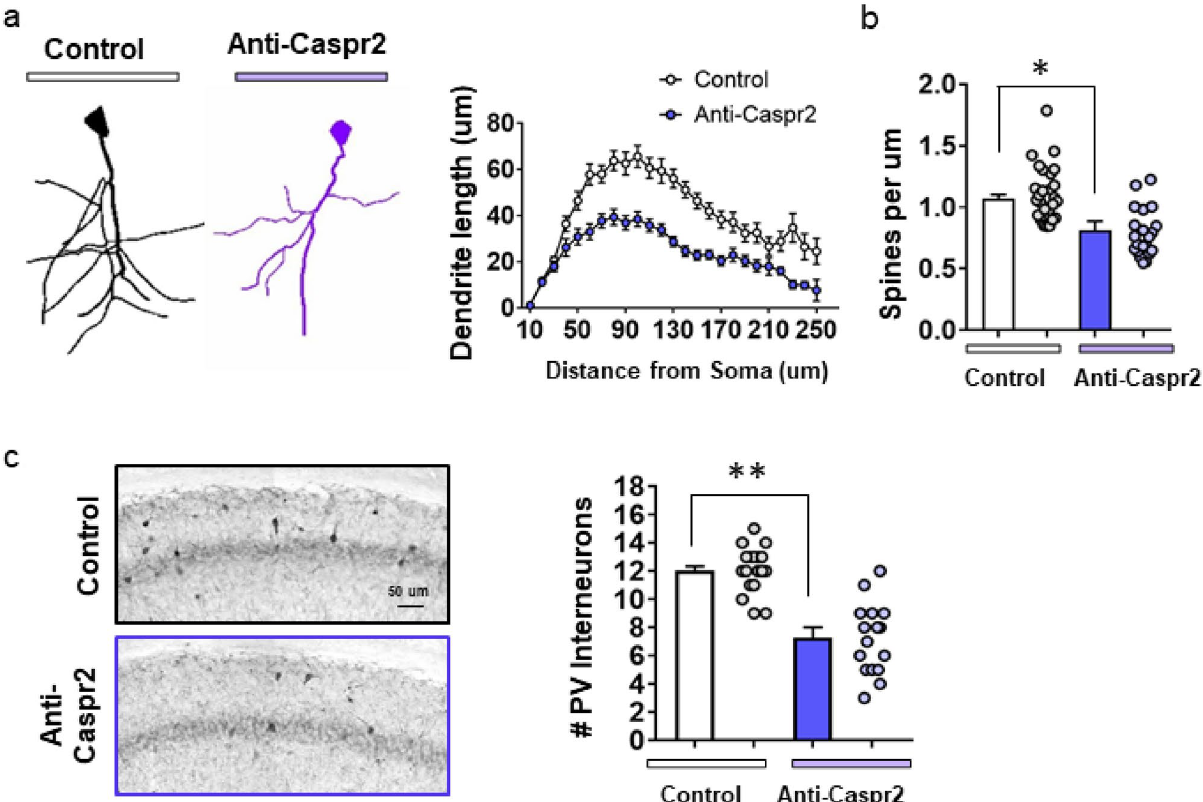
Figure 3. Male mice born to dams immunized with Caspr2 showed reduced dendritic arborization in pyramidal neurons and a reduced number of parvalbumin (PV) GABAergic interneurons. ( A ) Analysis of dendritic complexity in adult male mice exposed in utero to anti-Caspr2 (Anti-Caspr2, n = 5, 3 litters) or Control IgG (Control, n = 5, 4 litters). Left, tracings of CA1 neurons using Neurolucida360 (MBF, Williston VT), visualized with the Golgi method of silver staining. Right, Sholl analysis, male mice exposed in utero to Anti-Caspr2 IgG show decreased length of dendrites. Number of neurons = 44 per group. Mixed model linear analysis, P < 0.0001, ICC = 8%. ( B ) Analysis of the average number of synaptic dendritic spines per length in each mouse show reduced density of spines in CA1 neurons in mice exposed in utero to anti-Caspr2 IgG. Dots represent individual dendrites from which spines were counted, t-test, t(11) = 3.389, * P < 0.01. (Control, Anti-Caspr2, n = 4, 3 litters per group). ( C ) Analysis of the average counts of PV + GABAergic interneurons in the CA1 region. Dots represent number of individual PV + per section. t-test, t(9) = 6.639, * * P < 0.001, (Control n = 6, Anti-Caspr2 n = 5, 4